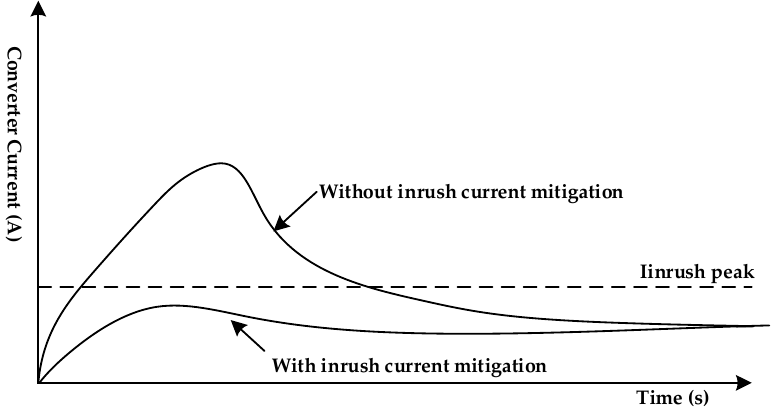
Figure 3. Inrush current at the startup operation of DC–DC converter.